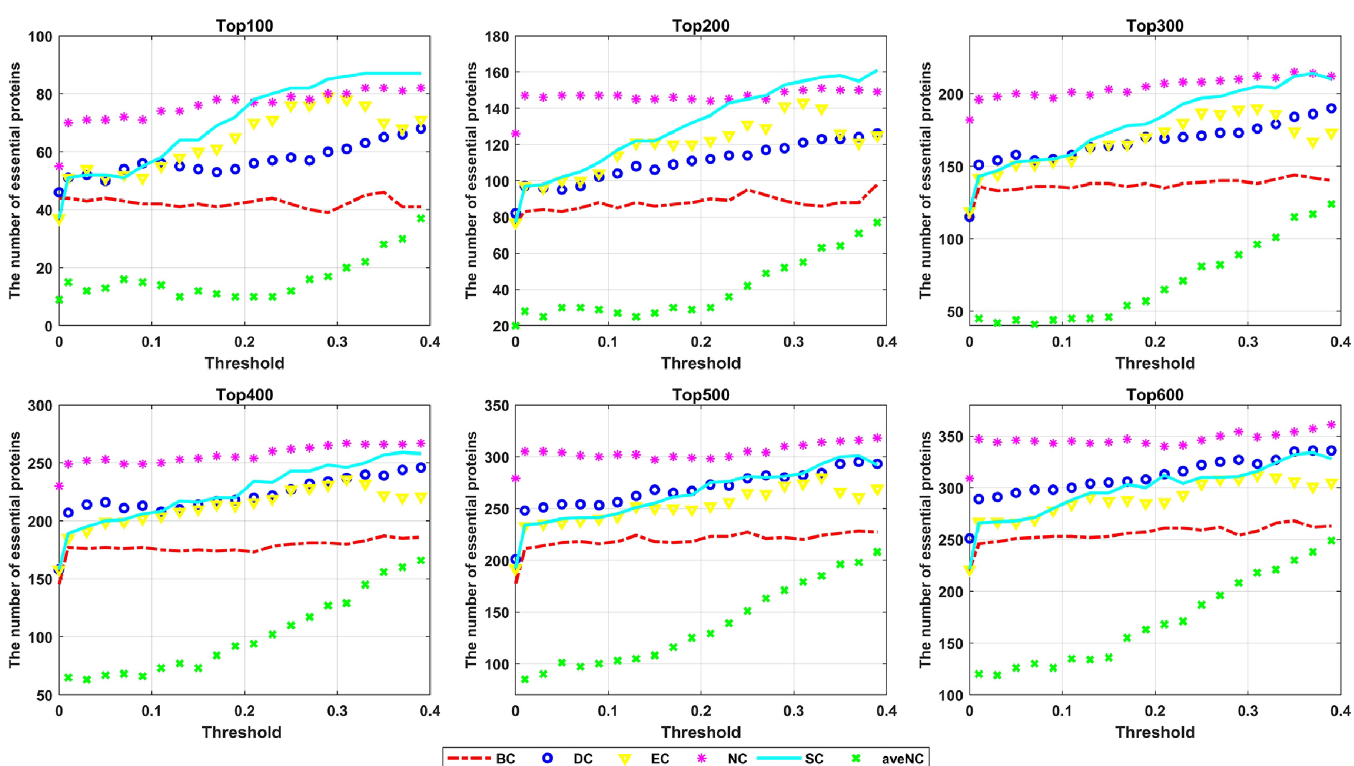
Fig 6. The numbers of correctly identified key proteins among the top 100, 200, 300, 400, 500, and 600 candidates for different method vs the threshold value.